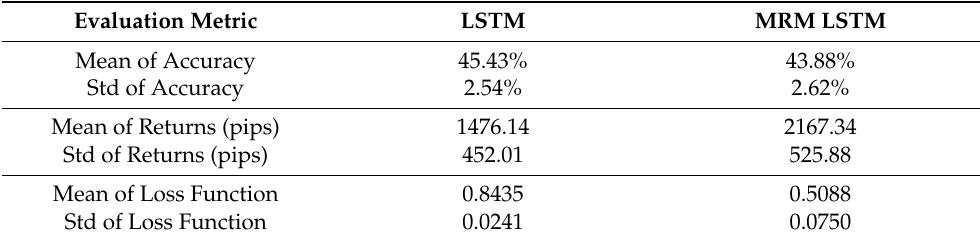
Table 2. Accuracy, Returns, and Training Loss for each